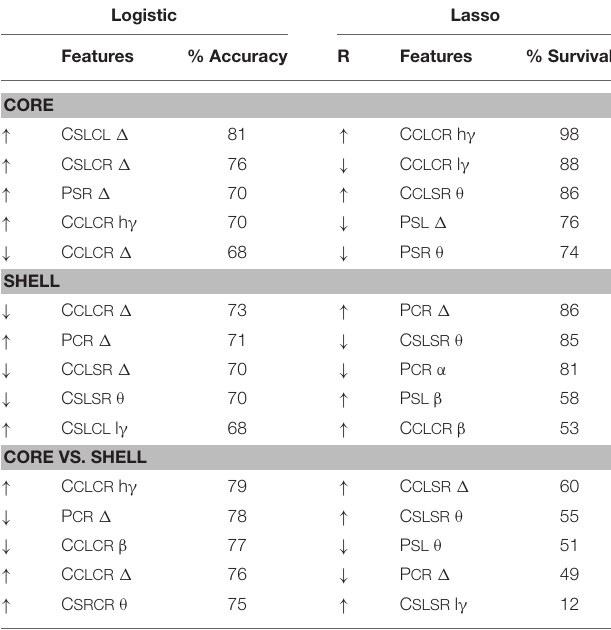
TABLE 1 | Top 5 LFP Features for Each Model